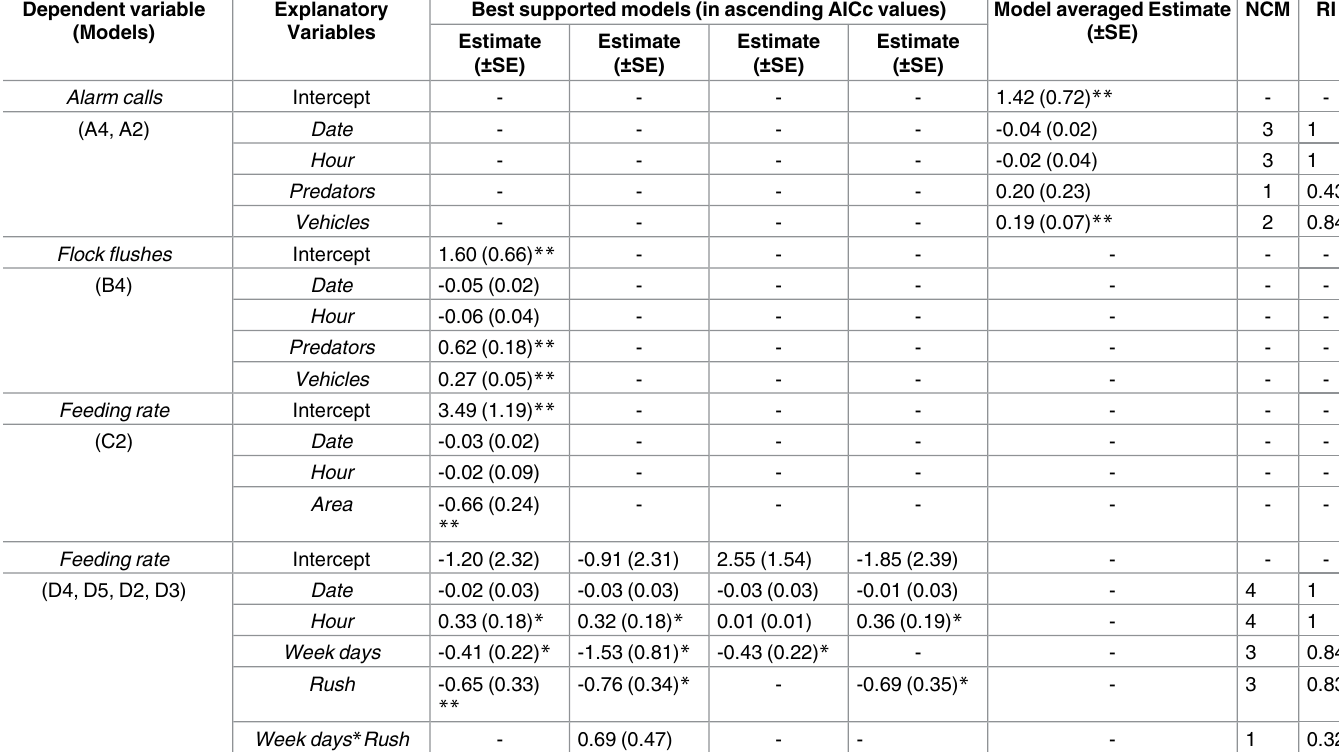
Table 2. Parameter estimates ( ± SE) for the terms contained in the best supported models explaining: risk-avoidance behaviors (A and B) and fac- tors affecting parental feeding (C and D). Dependent variable (Models)